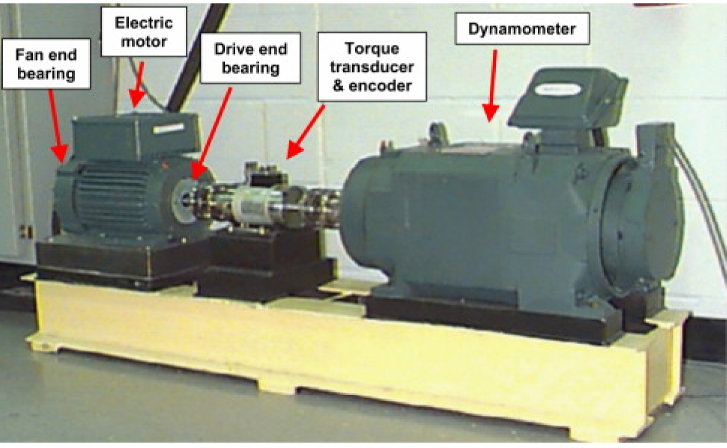
Figure 6. CWRU test bench